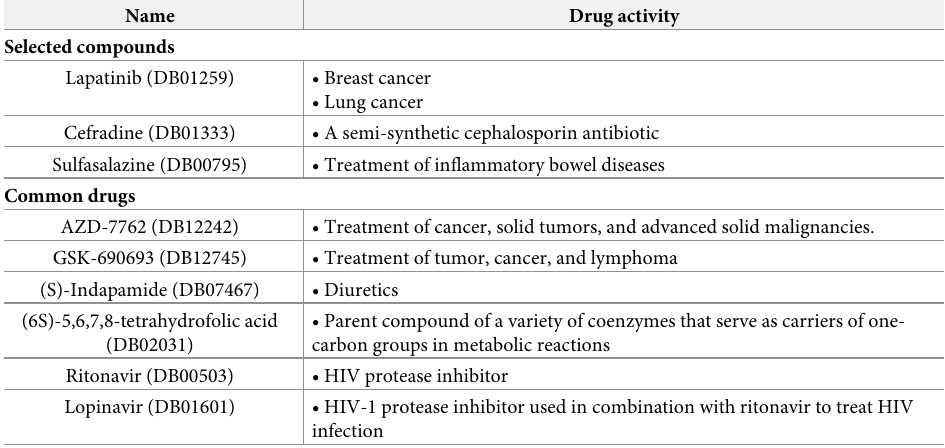
Table 1. The selected compounds and common drugs for SAR-CoV-2 3CL pro inhibitory activity